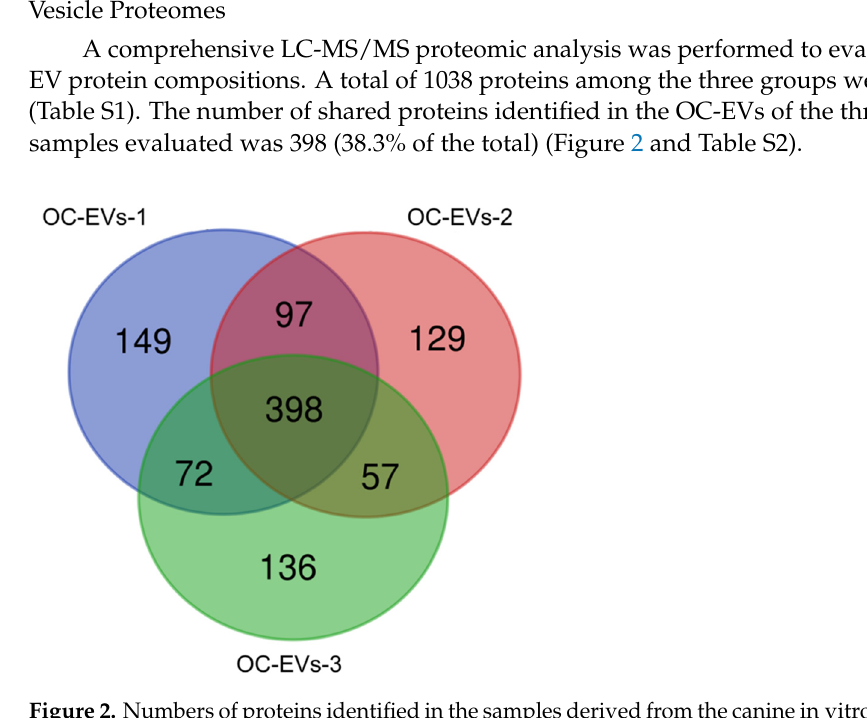
Figure 2. Numbers of proteins identified in the samples derived from the canine in vitro oviductal cell-derived extracellular vesicles. Venn diagram showing 398 shared proteins between three biological samples of canine in vitro oviductal cell-derived extracellular vesicles.